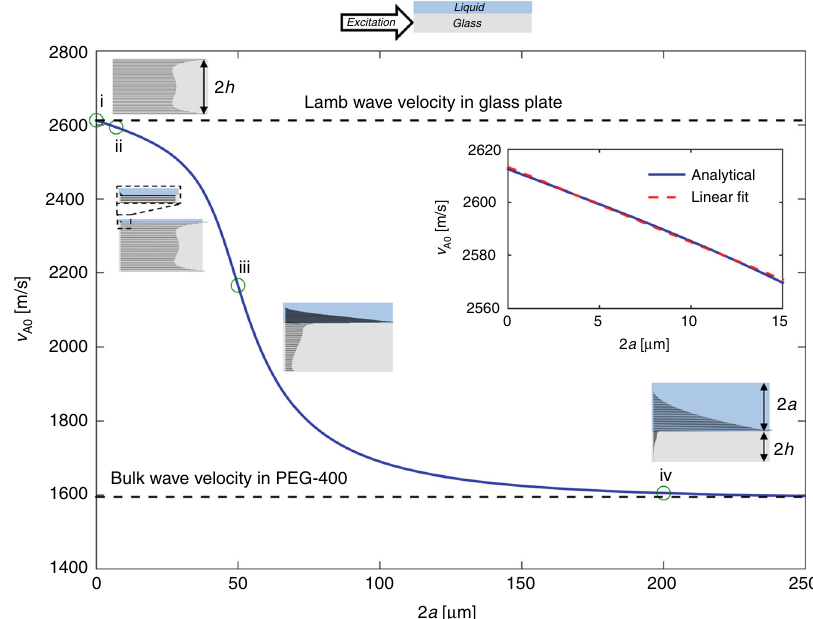
Fig. 4 Wave properties at the interface of a glass plate with different thicknesses of liquid loading. The phase velocity and the corresponding power density plot of liquid loading on a glass plate at different thickness (i) 0 µ m, (ii) 1 µ m, (iii) 50 µ m, and (iv) 200 µ m. The inset shows that when the liquid layer thickness is small (2 a ≪ 2 h ), the Lamb-type wave coupling into the liquid is small. When the layer thickness is such that (2 a < 15 μ m), the guided wave wavelength of the antisymmetric mode decreases linearly from λ = 269.1 μ m to λ = 264.6 μ m and can be represented by a linear expression λ